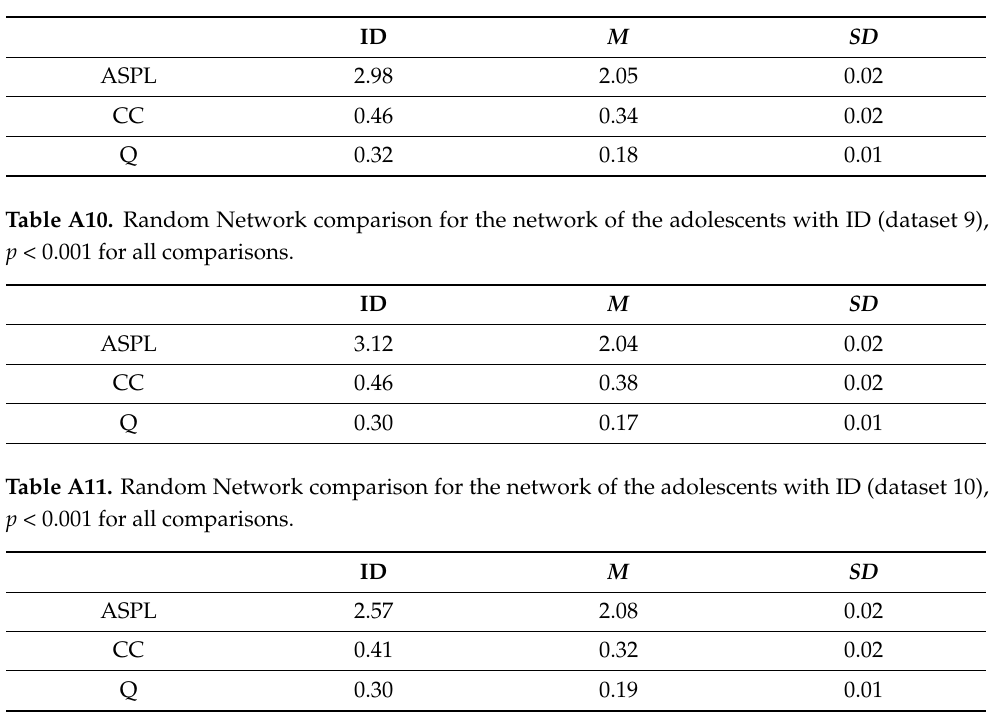
Table A9. Random Network comparison for the network of the adolescents with ID (dataset 8), p < 0.001 for all comparisons.